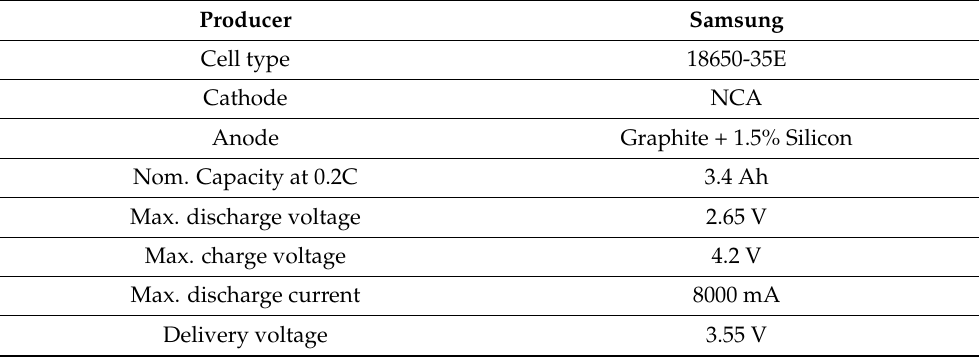
Table 1. Datasheet of 18650-35E Samsung.